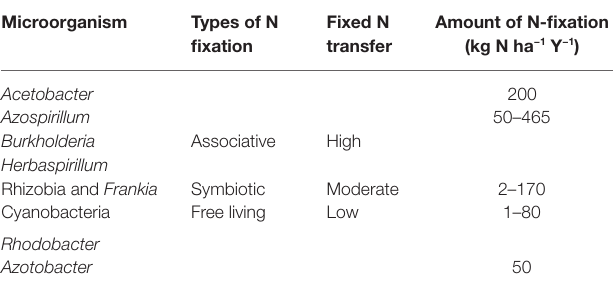
TABLE 1 | Estimated nitrogen fixation rates of diazotrophs. Microorganism Types of N Fixed N fixation